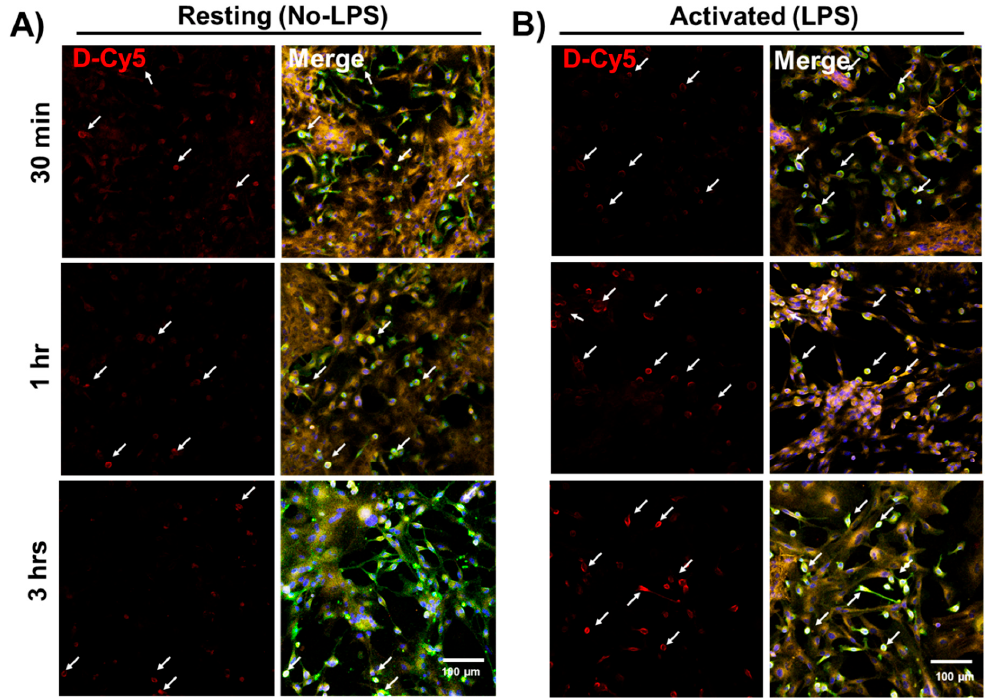
Figure 5. Time-dependent (30 min–3 h) and differential dendrimer uptake between resting and activated microglial cells in mixed glial cultures from neonatal rabbit brain. The mixed glial cultures were activated using LPS (100 ng/mL) and treated with 20 μ g/mL of D-Cy5. At different time points (0.5, 1, 3, 6, and 24 h) post-D-Cy5 treatment, the cells were fixed and stained with lectin for microglia (Green), GFAP for astrocytes (Orange), and DAPI for nucleus (Blue). ( A ) Resting (no-LPS) microglia/macrophages show less dendrimer uptake compared to ( B ) activated (LPS) microglia/macrophages at all time points (white arrows). Scale bar 100 μ m.